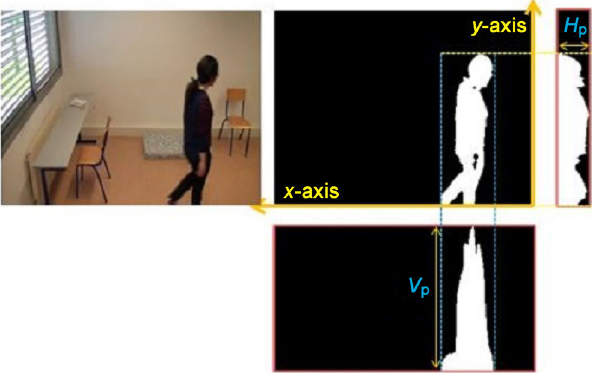
Fig. 7 Human silhouette projection histogram. Fig. 8 Directions of